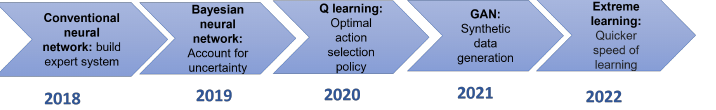
Figure 13. Neural network evolution. Figure with arrows indicating change in ANN over